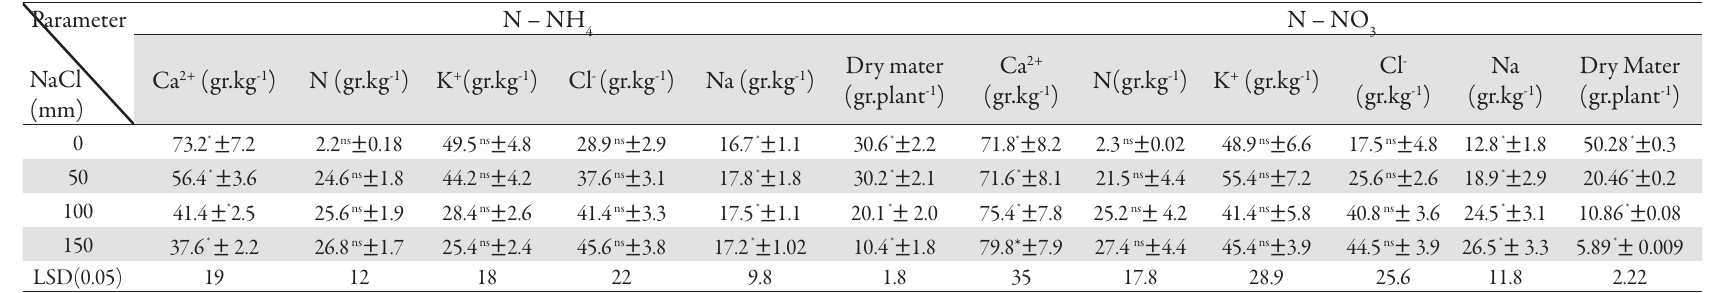
Tab. 1. Effect of salinity rates in different N - forms on dry matter and nutrient concentration Parameter